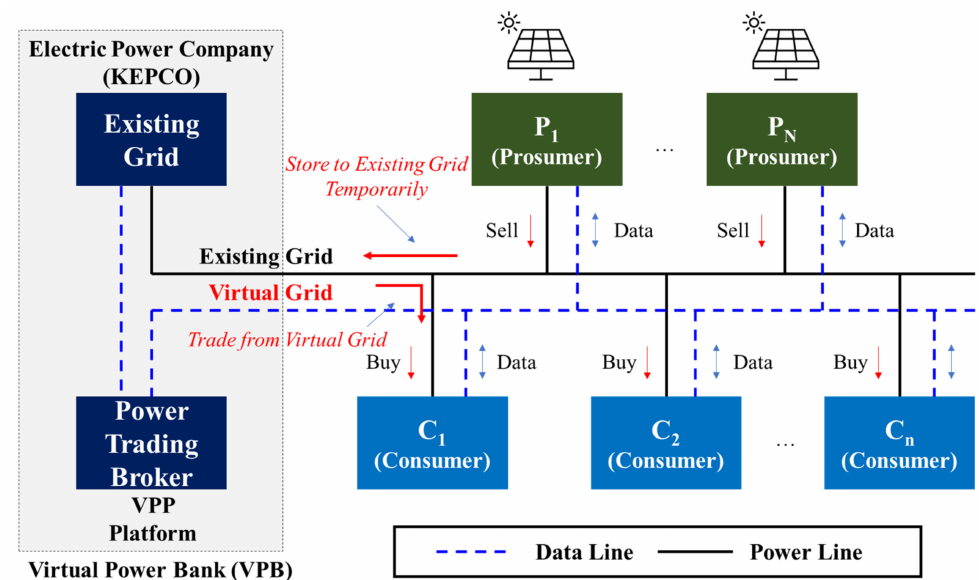
Figure 3. VPB-based power trading